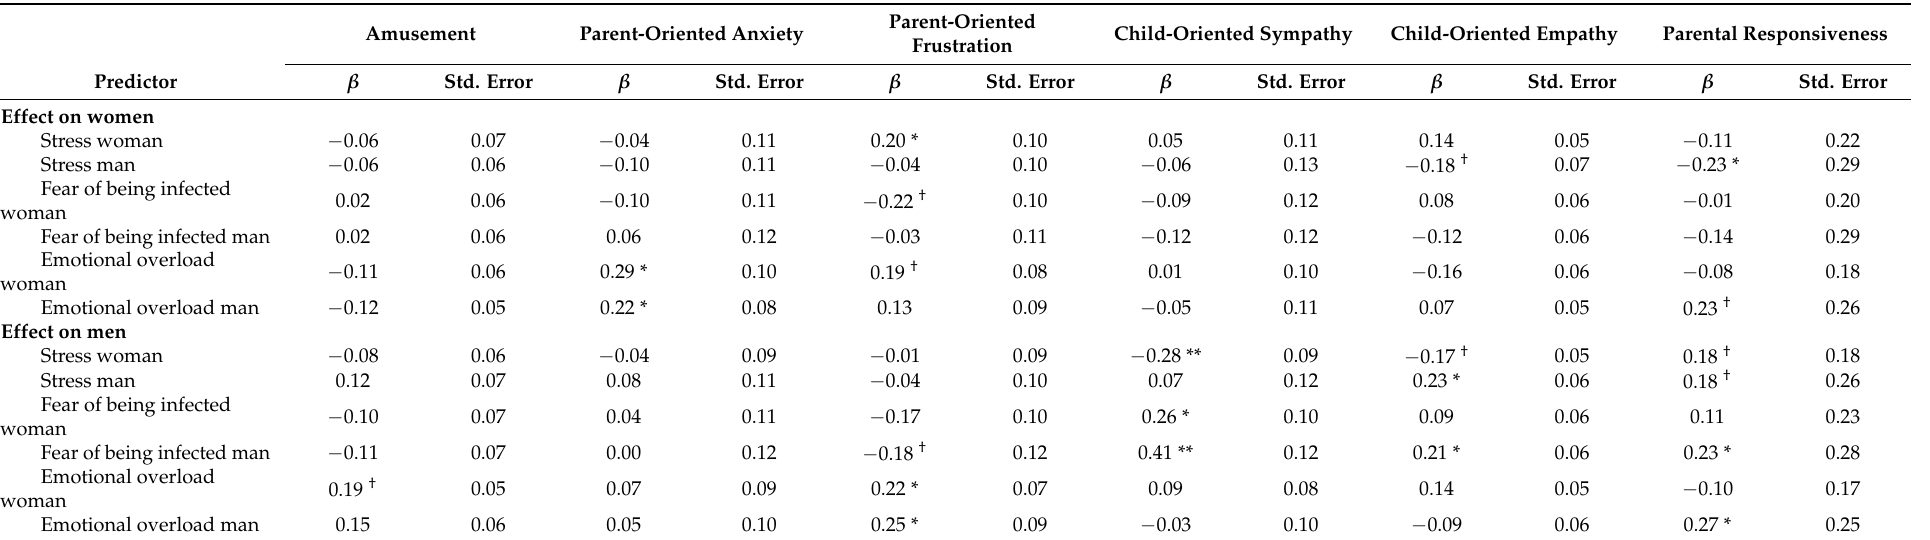
Table 2. Results of the Actor–Partner Interdependence Models with standardized coefficient estimates. Amusement Parent-Oriented Anxiety